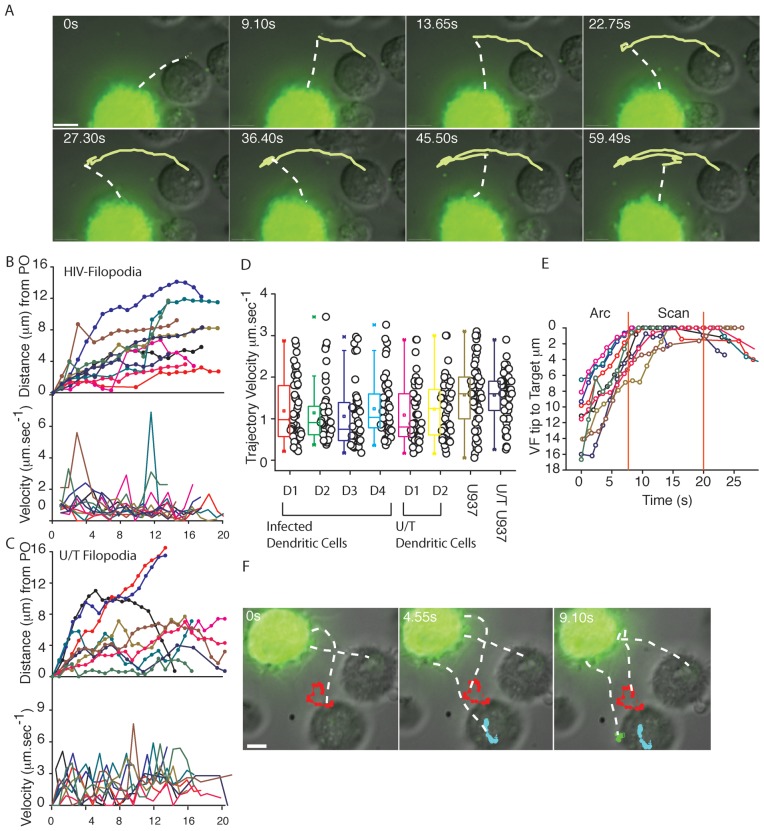
VF trajectories engage in fast overlapping Arc trajectories prior to engaging and scanning CD4 T cells.DC were infected with HIV-iGFP and subsequent live imaging proceeded with infected DCs co-culture with CD4 T cells at a ratio of 1 DC to 3 CD4 T cells as outlined in Fig. 1. (A) Untethered VF engage in sweeping Arc trajectories. To illustrate the overall movement of VF, 8 frames of the Supplementary Video S5 were superimposed. To highlight filopodia, a dashed line shadows the filopodial connection on VF as in Fig. 1. (B) 10 representative velocities of VF tips over time (lower graph) and corresponding movements from their point of origin (PO) (upper graph) (C) 10 representative velocities of filopodia from uninfected DC from the same donor. (D) Average velocities across entire VF trajectories across multiple DC donors and filopodial trajectories from untreated (U/T) controls (each point is the average VF Velocity over an entire 20 second trajectory). VF and filopodia from infected and untreated (U/T) U937 monocyte cell line is presented herein as a comparison. (E) Change in VF trajectories from Arc to Scan movements, when contacting CD4 T cells. The distance of the VF tip to the target T cells was calculated over time for 10 representative VF. Vertical red lines highlight the average scanning time of filopodia on the CD4 T cell membrane. Although scanning by normal filopdoia occurs, we could not resolve definitive trajectories as we did not have a tip marker equivalent to HIV on VF. (F) To illustrate the appearance of Scan trajectories in close contact with CD4 T cells, 3 frames have been taken from a live imaging time lapse experiment in Video S5, and single particle tracking over time highlighted in each frame. All scale bars are at 5 µm. All data is representative of in excess of 12 independent donors.